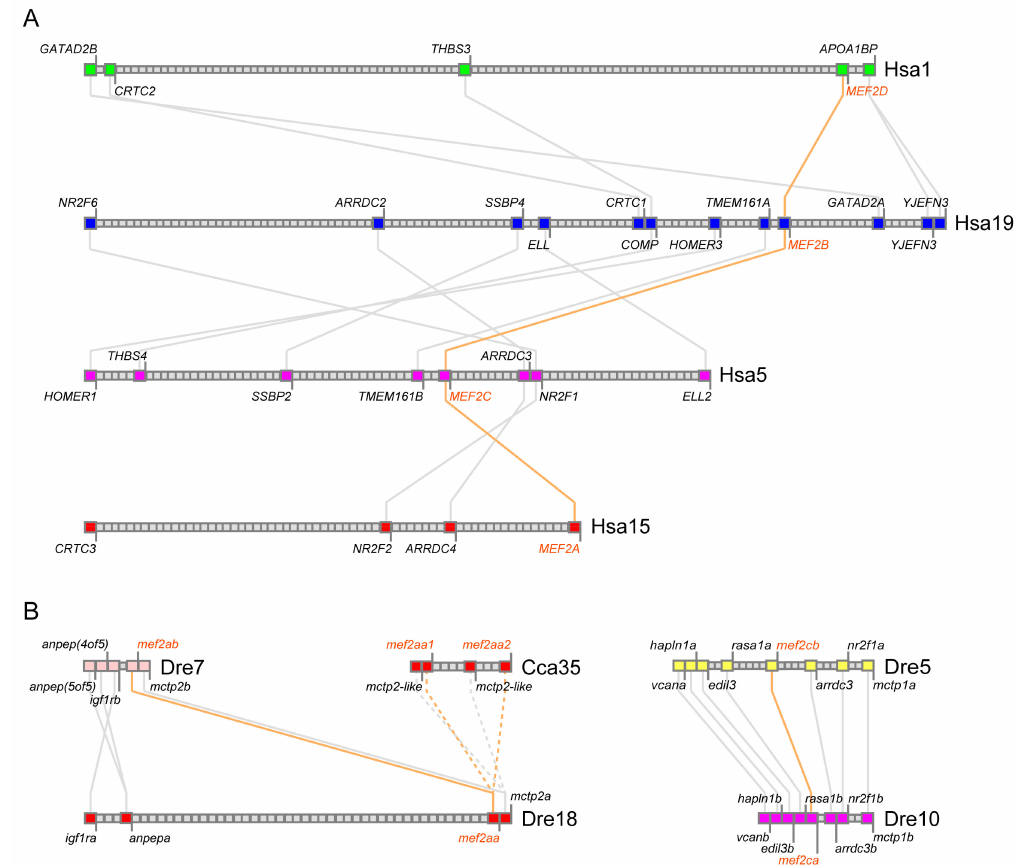
Figure 3. Conserved synteny analysis with mef2 genes of Homo sapiens ( A ), Danio rerio and Cyprinus carpio ( B ). In each species, squares of the same color represent genes belonging to a syntenic cluster, with gene names indicated beside. Species and chromosome number are labeled on the right of each cluster (Hsa: H. sapiens ; Dre: D. rerio ; Cca: C. carpio ). Solid and dashed lines connect paralogous and orthologous gene pairs, respectively. For simplicity, lines between Hsa1 and Hsa5, Hsa1 and Hsa15, as well as Hsa19 and Hsa15 are not shown. All mef2 genes and their connections are highlighted in